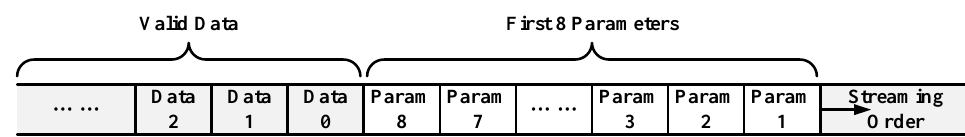
Figure 15. On-chip Memory System.